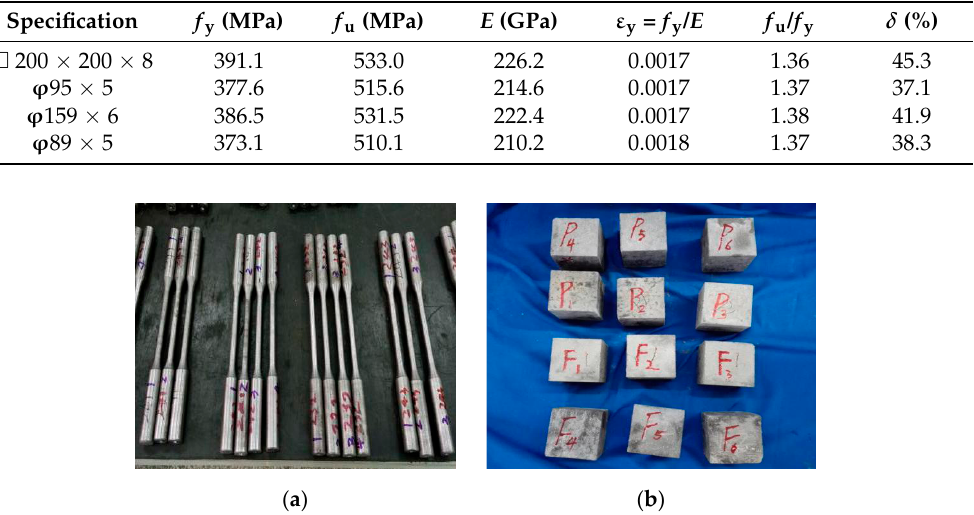
Figure 2. Samples of experimental materials. ( a ) The standard specimens of Q345; ( b ) The standard specimens of concrete. Table 2. Test result of steel tubular material properties.